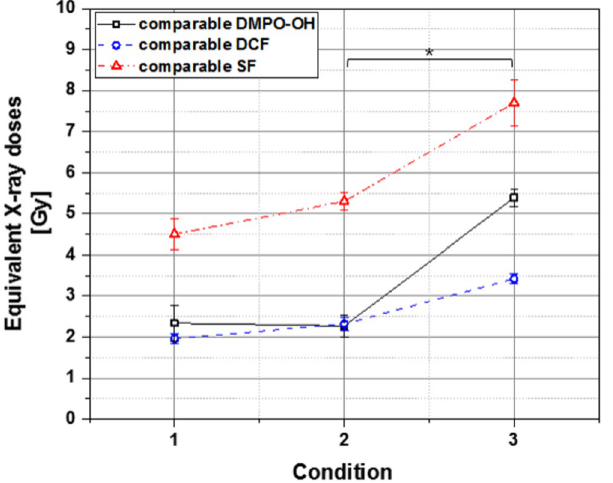
Figure 8. The equivalent X-ray doses in DCF fluorescence and DMPO-OH signal productions, and the fractional clonogenic cell death observed in MECs after plasma treatment under three (1, 2, and 3) operational conditions of APPJ device. Each data point was obtained from three to five independent experiments. Error bars indicate one standard error for individual mean values. The asterisk indicates that the equivalent X-ray doses of operational conditions 2 and 3 are significantly different from each other (p < 0.05) with regard to medium OH and intracellular ROS productions and clonogenic cell